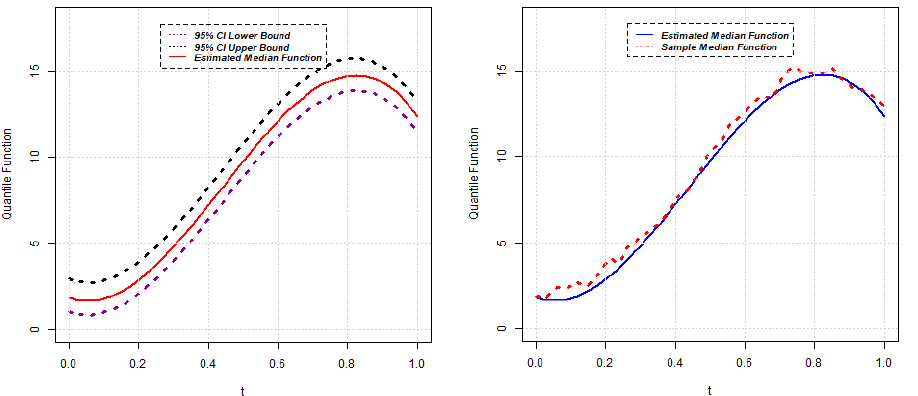
Figure 3. Estimated median function and C.I. ( left ); Estimated median and sample median ( right ) for Model 3.